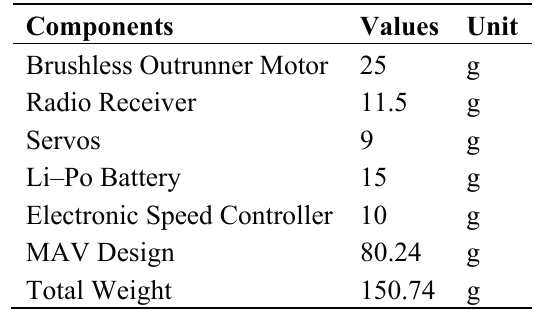
Figure 55. Single flapping wing. Table 6. Total weight of micro air vehicles